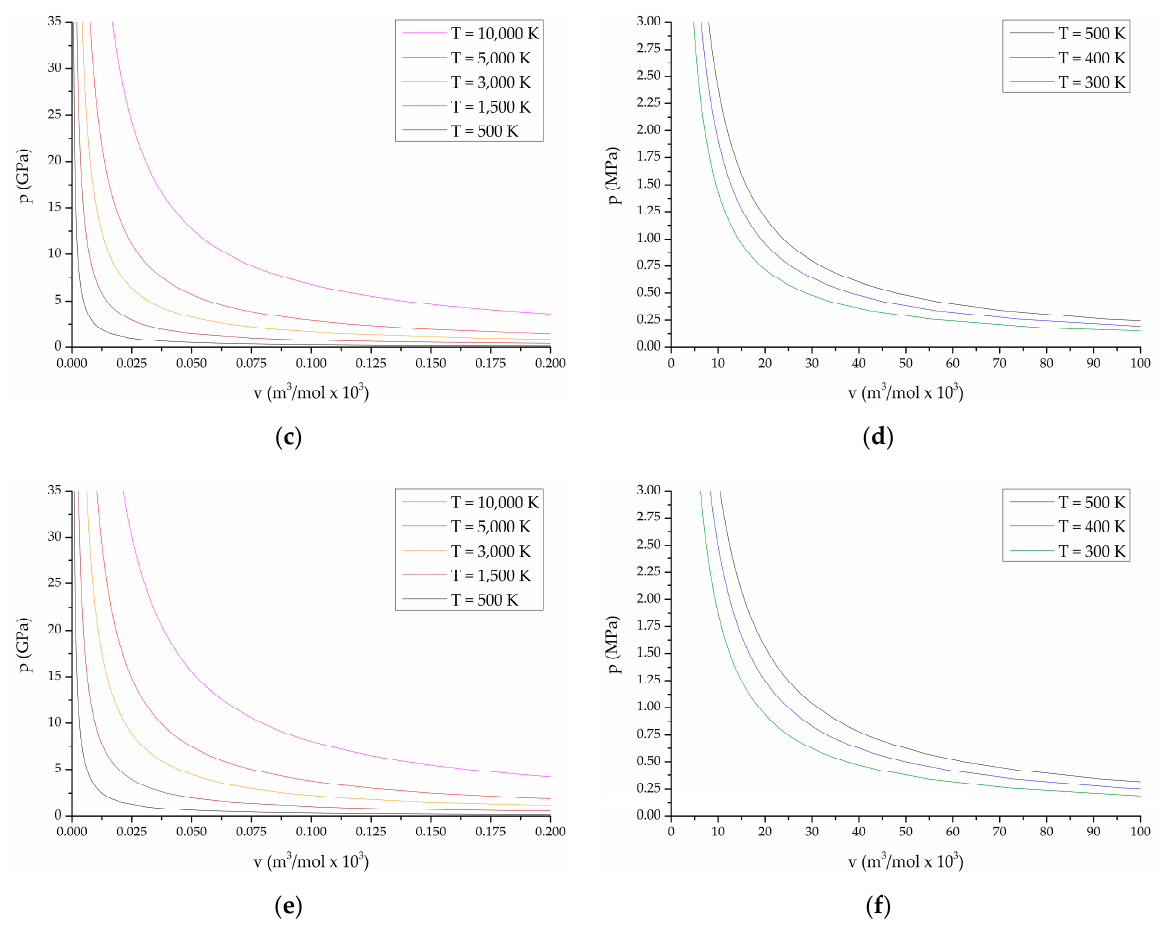
Figure 1. P ‐ V diagrams of reaction products from the state of compressed cold plasma to normal temperature: ( a , b ) TTDA; ( c , d ) TTGA; ( e , f ) DNTT.